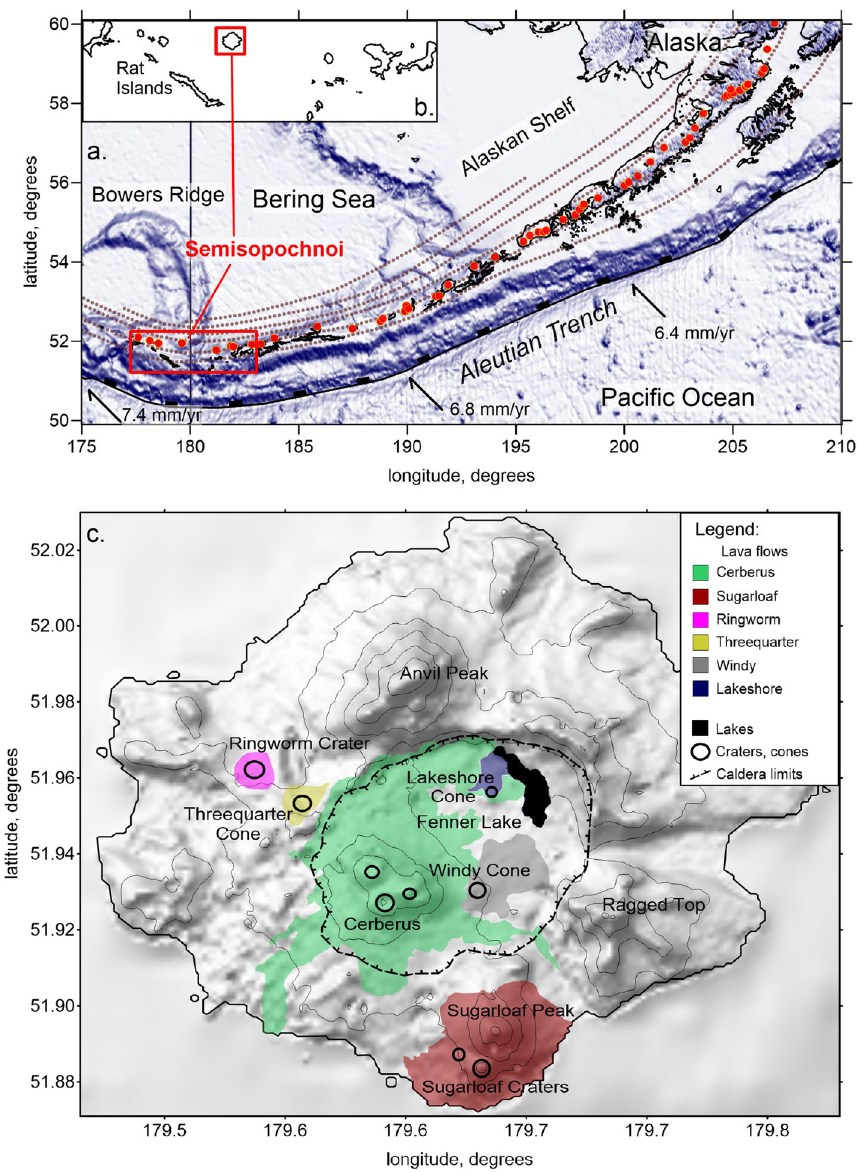
Figure 1. Location and general structural units of Semisopochnoi Island. ( a ) Bathymetry map of the Aleutian Arc with the location of the main Holocene-aged volcanoes (red dots), the shape of the subducted Pacific Plate (brown dotted lines), and plate movement vectors 16 . ( b ) Location of Semisopochnoi in the Rat Island Group. ( c ) Topography map of Semisopochnoi Island indicating lava flows and the main structural elements (modified from Coombs et al. 12 ). The figure was generated using the software Surfer (version 13, http:// www. golde nsofw are. com/ produ cts/